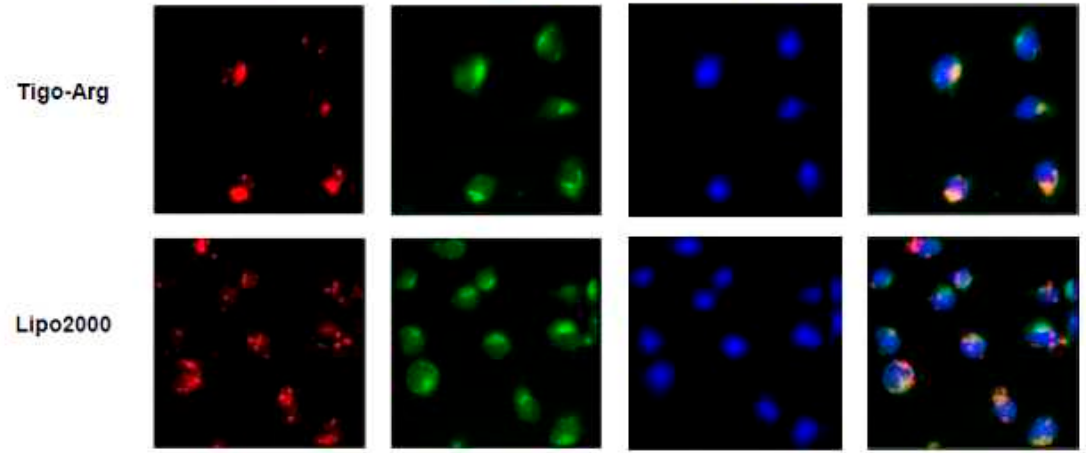
Figure 8. Fluorescence images (400 × ) for intracellular localization of the steroid-based cationic lipids/Cy3-pDNA lipoplexes after 4 h incubation in H1299 cells. Lipofectamine2000 (Lipo2000) was used as a reference. Red: Cy3-labeled pDNA; green: Lysotracker stained endosome/lysosome; blue: DAPI stained cell nuclei.